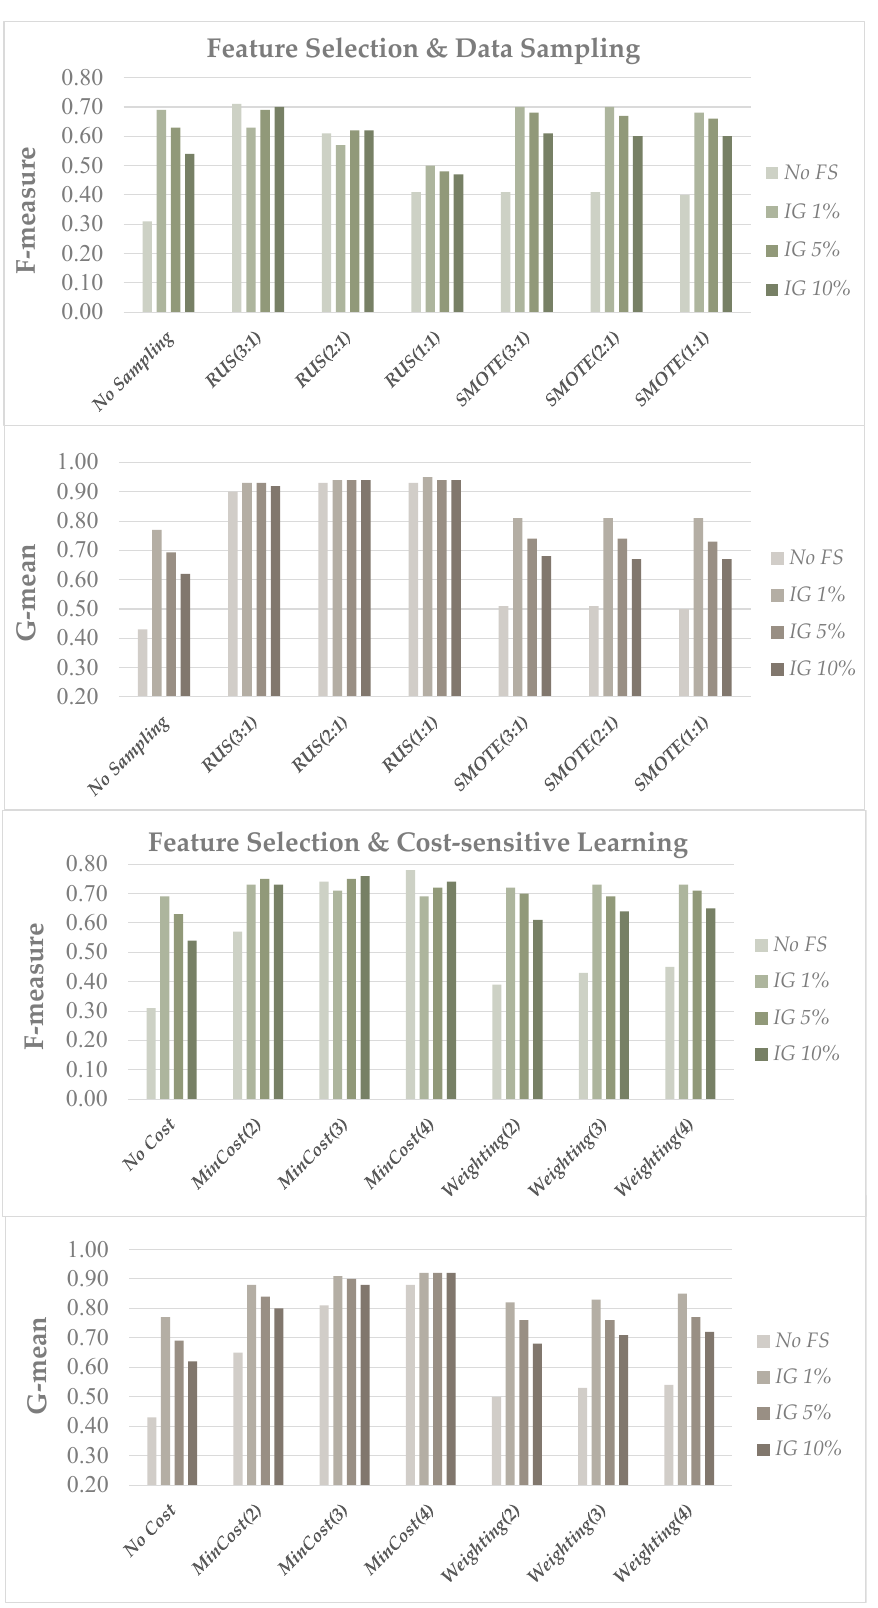
Figure 3. Trade dataset: F-measure and G-mean performance of the RF classifier in conjunction with feature selection (IG ranker) and imbalance learning methods (data sampling and cost-sensitive learning), for different percentages of selected features (1, 5 and 10% of the original data dimensionality).